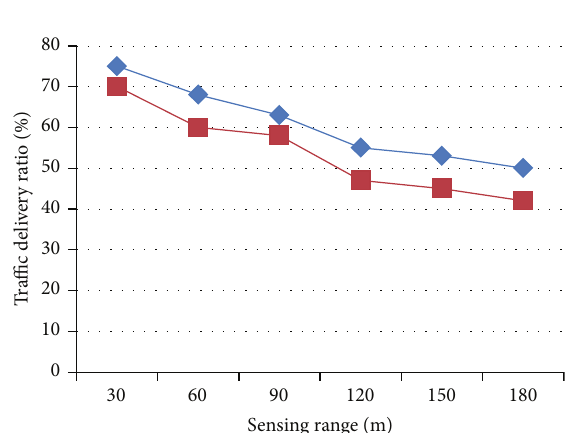
Figure 7: Measure of integrity.